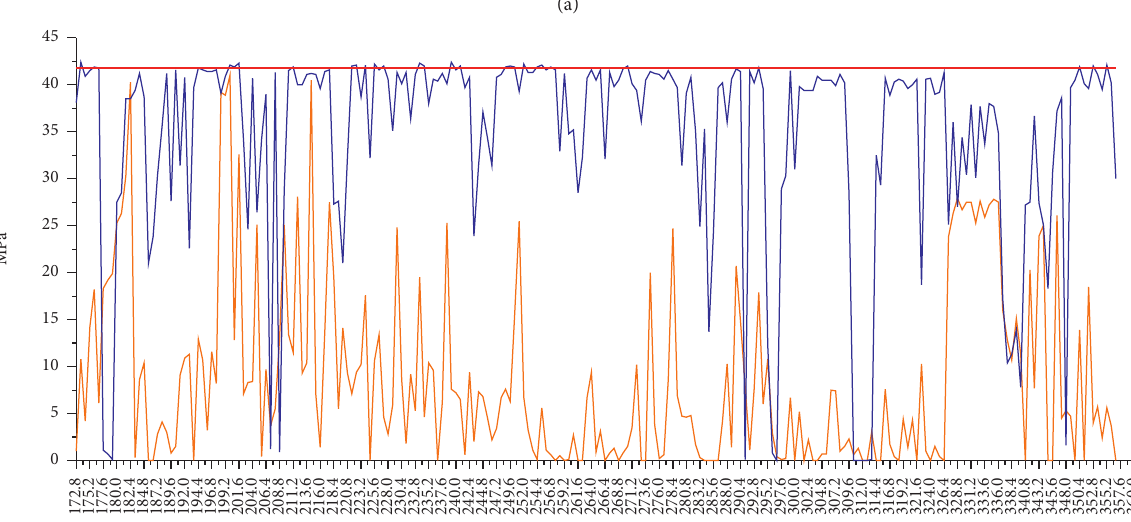
8175 . 2177 . 6180 . 0182 . 4184 . 8187 . 2189 . 6192 . 0194 . 4196 . 8199 . 2201 . 6204 . 0206 . 4208 . 8211 . 2213 . 6216 . 0218 . 4220 . 8223 . 2225 . 6228 . 0230 . 4232 . 8235 . 2237 . 6240 . 0242 . 4244 . 8247 . 2249 . 6252 . 0254 . 4256 . 8259 . 2261 . 6264 . 0266 . 4268 . 8271 . 2273 . 6276 . 0278 . 4280 . 8283 . 2285 . 6288 . 0290 . 4292 . 8295 . 2297 . 6300 . 0302 . 4304 . 8307 . 2309 . 6312 . 0314 . 4316 . 8319 . 2321 . 6324 . 0326 . 4328 . 8331 . 2333 . 6336 . 0338 . 4340 . 8343 . 2345 . 6348 . 0350 . 4352 . 8355 . 2357 . 6360 . 0 172 .